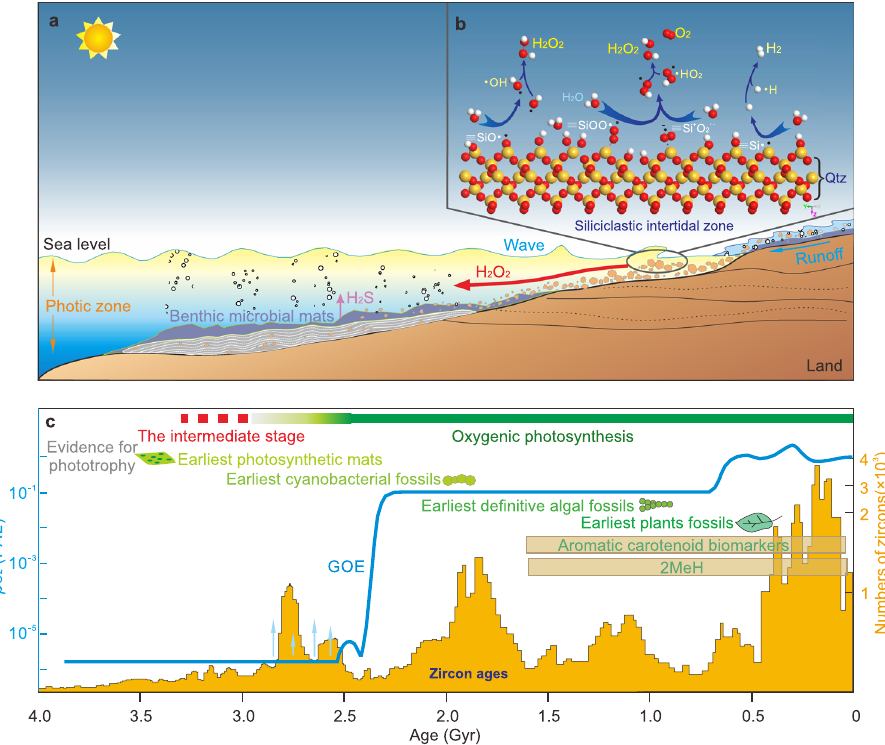
Fig. 4 A plausible origin of oxygenic photosynthesis from an anaerobic photosynthetic community with the supply of H 2 O 2 released at mineral-water interface along the siliciclastic intertidal zone. a The H 2 O 2 -induced evolutionary impetus on the organisms that conduct anoxygenic photosynthesis in microbial mats. b H 2 O 2 generated at the quartz-water interface in the high-energy hydrodynamic intertidal zone. c Geological constraints on the origin of oxygenic photosynthesis including data from the body and molecular fossil (lipid biomarker) records, the age distribution of zircons and the oxygen concentration relative to the present atmospheric level (PAL). Modi fi ed from Fischer 4 , Lyons 58 , and Hawkesworth 69